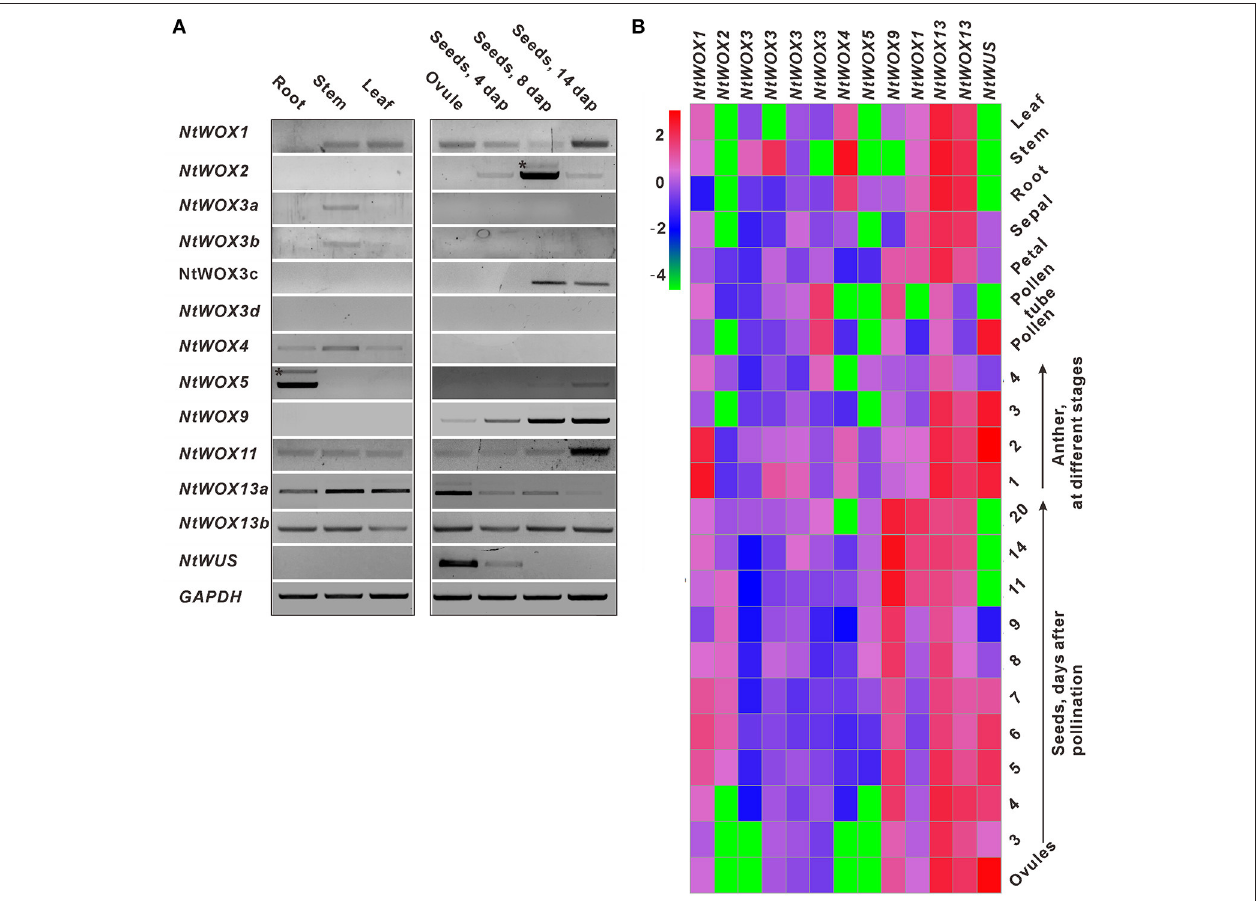
FIGURE 2 | Expression pattern analysis of WOXs in tobacco. (A) RT-PCR analysis of the expression of WOXs . cDNA prepared from root, stem, leaf, ovule, and seeds at different stages were selected as templates for PCR. GAPDH was used as the control. * indicate no specific bands. (B) Expression profile of WOX s in tobacco, which was constructed based on the relative expression level of WOXs in different tissues. The expression level was normalized to the average expression level of GAPDH (AJ133422), polyubiquitin (GQ281244). Each data represents the mean of three biological repeats. A red box indicates a higher expression level, whereas a green box indicates the lower expression level. Anthers at stages 1–4 correspond to anthers containing microspore mother cells, tetrads, single-nucleated pollen, and bi-nucleated pollen, respectively. The scale bar represents the fold change (log10